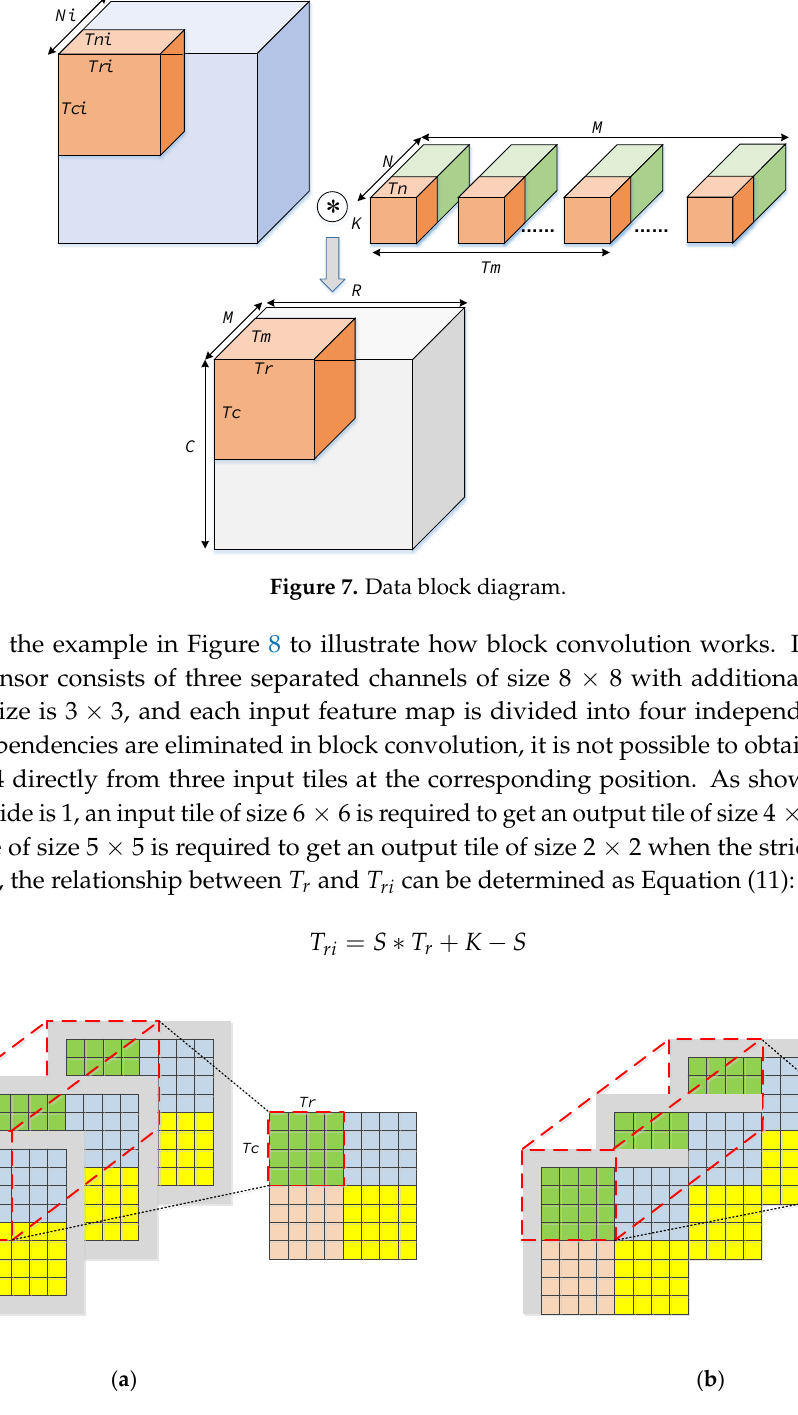
Figure 8. An example of block convolution: ( a ) The stride of convolution is one; ( b ) The stride of convolution is two.